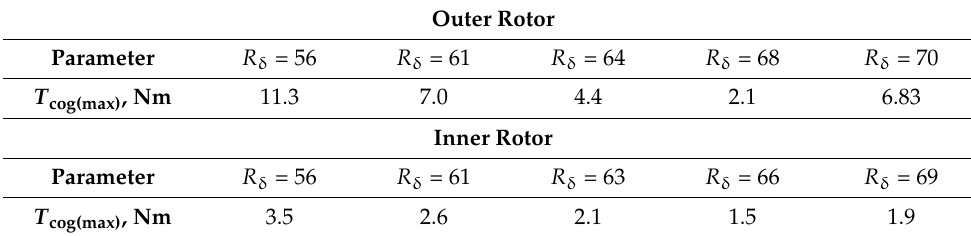
Table 2. Cogging torque values of the TFM with an outer and inner rotor at various air-gap radii.